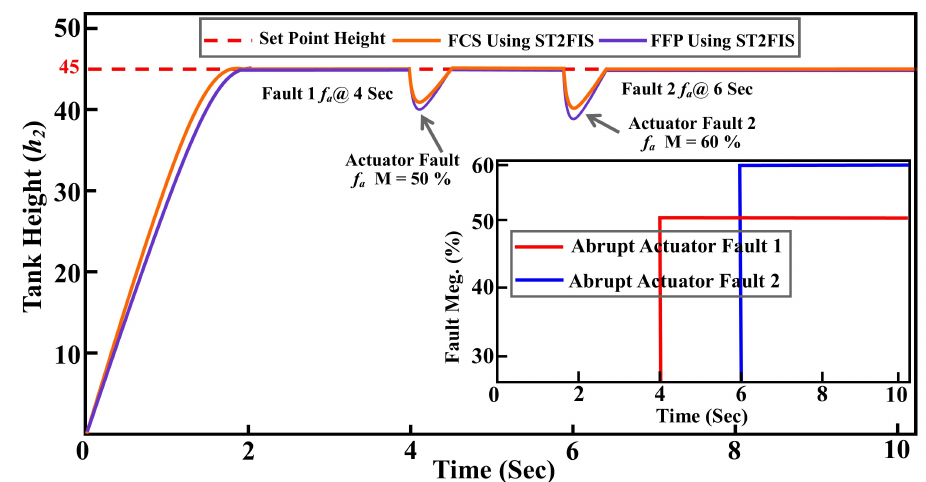
Figure 13. Comparative results of TTCFNLC process subject to actuator fault using fuzzy CS and FP algorithms.